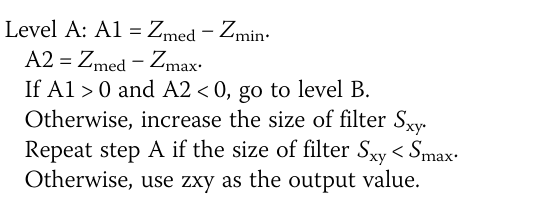
Table 2 Detection results of medium-wave image processing system Project